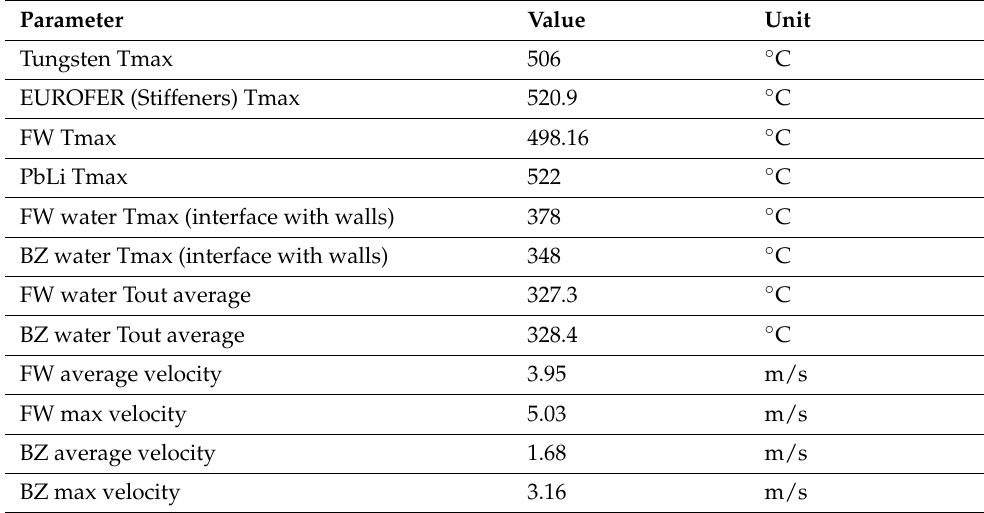
Figure 8. Radial–poloidal contour of the hot spot within the PbLi region. The tungsten armor hot spot (506 °C) arises in the bottom area, before the second elbow, as shown in Figure 9. This is due to the fact that the shifted FW channel alone is responsible for the cooling of that area, without a counter ‐ current channel below. Figure 9. Temperature field at the tungsten external armor. The hot spot is placed in the bottom region, before the elbow. The average water temperature at the exit of the FW is 327.3 °C, whereas at the exit of the second BZ loop, the average temperature of the coolant is 328.4 °C. Therefore, the imposed mass flow rates satisfy the PWR operational thermal conditions. It is worth noting that the maximum water temperature for both the FW and BZ cir ‐ cuit exceeds the saturation temperature (344.8 °C at 15.5 MPa), with the temperatures be ‐ ing 378 °C and 348.7 °C, respectively. Local nucleate boiling should be expected which is not observed in CFX thanks to the numerical model being limited to a “single ‐ phase” state. On the other hand, larger heat transfer coefficients available in the nucleate boiling regime are going to reduce the maximum temperature locally. The possible occurrence of a thermal crisis within the coolant system has been eval ‐ uated. For horizontal tubes and high flow rates, according to Ref. [18], the critical heat flux (CHF) can be predicted using the correlation 𝑞 ” (cid:3004)(cid:3009)(cid:3007) (cid:3404) 𝑘𝑞 ” (cid:3004)(cid:3009)(cid:3007) , (cid:3023)(cid:3032)(cid:3045) . The parameter 𝑘 varies with the Froude number 𝐹𝑟 (cid:3404) 𝐺 (cid:2870) / (cid:4666)𝜌 (cid:2870) 𝑔𝐷(cid:4667) , where 𝐺 is the total mass flux (kg/m 2 s), 𝜌 is the density of the saturated liquid at 15.5 MPa (kg/m 3 ), 𝑔 is the gravity acceleration (m/s 2 ),